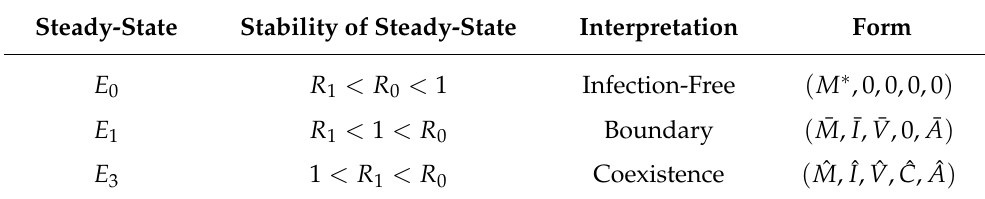
Table 2. Steady states of the model. Equilibria E 2 and E 4 are never biologically relevant, so they are omitted. Thresholds and steady states were determined in